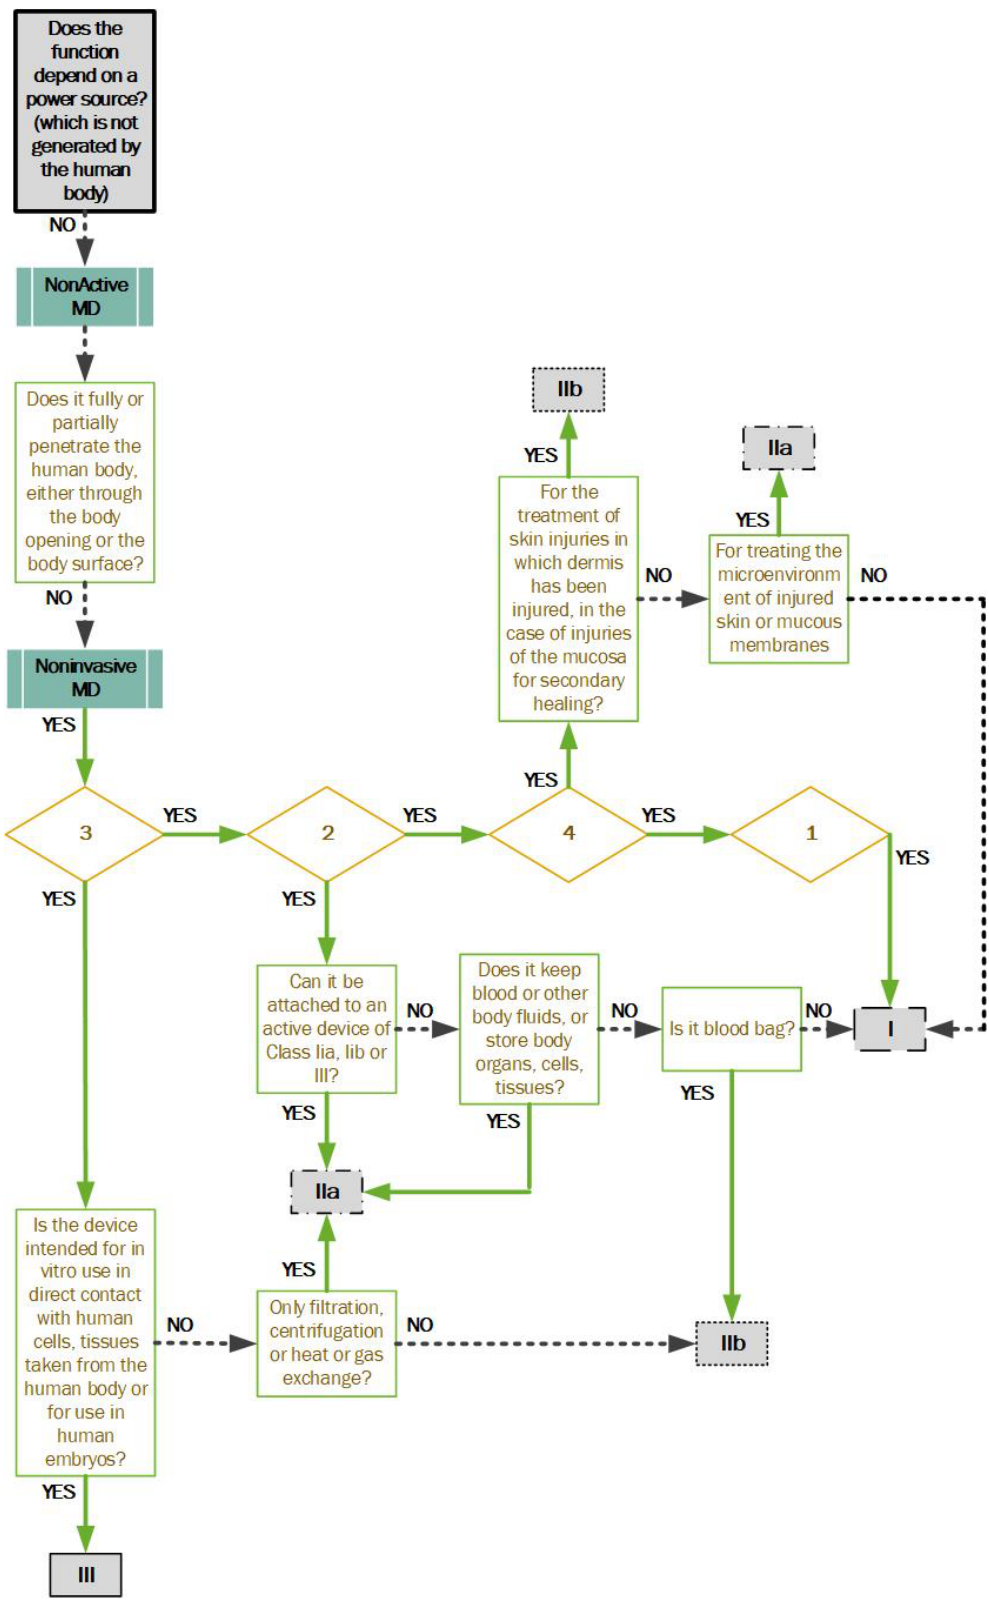
Figure 3. The third phase of the decision.